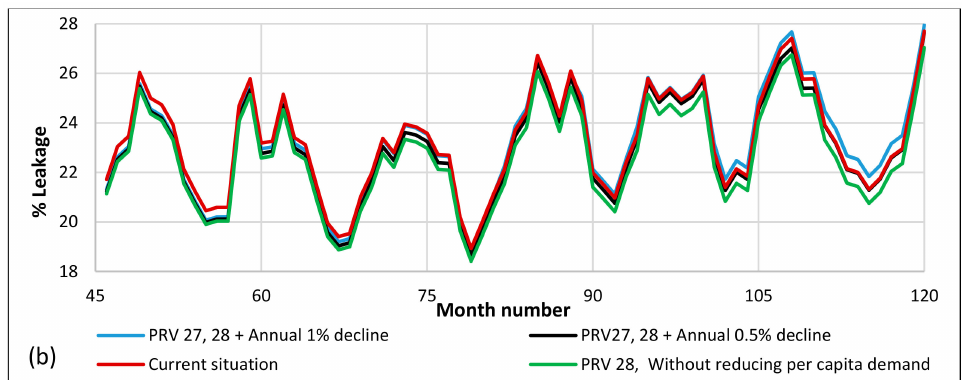
Figure 16. Comparison between the best results in the 2nd and 4th scenarios; ( a ) VI, ( b ) %Leakage.